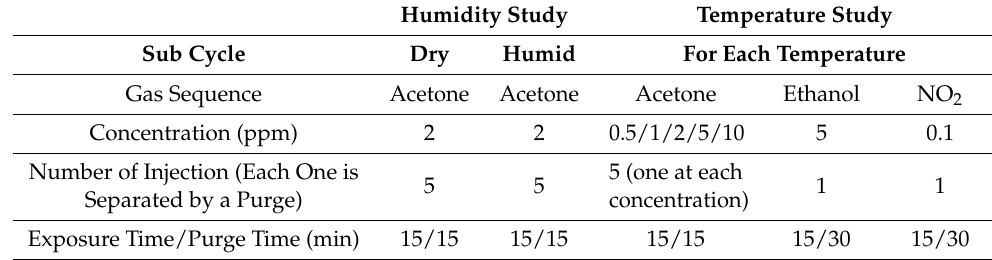
Table 5. Summary of gas injections and their respective concentration, number of injections, exposure and purge time used in humidity and temperature studies.